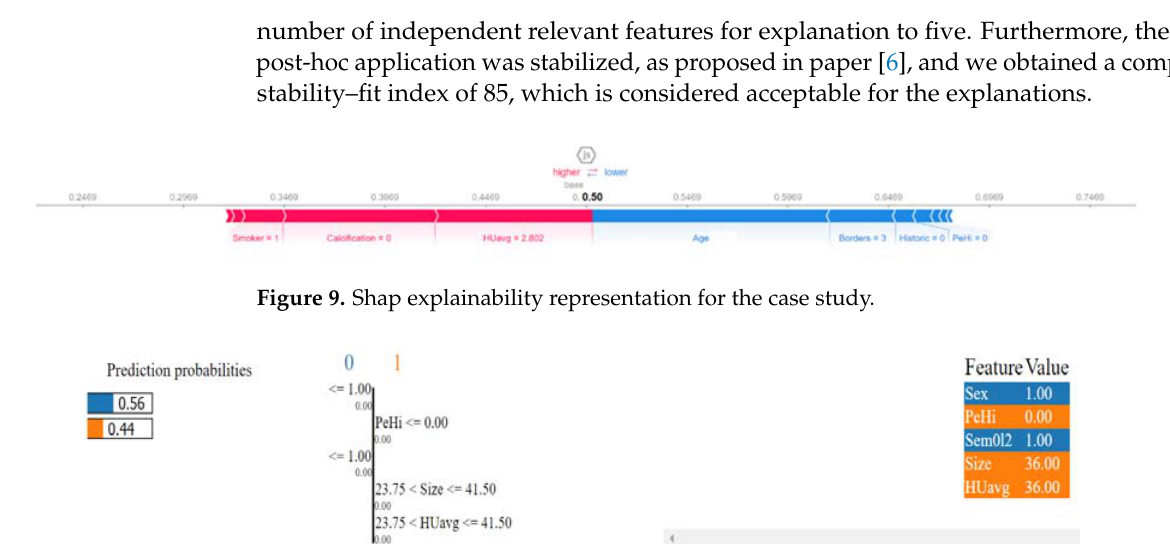
Figure 8. Global feature importance. SHAP explainable plot .